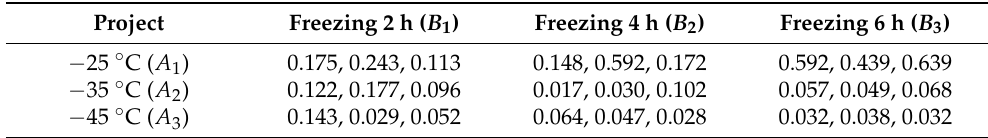
Table 9. Adhesion strength of AL-Ice-AL test piece.